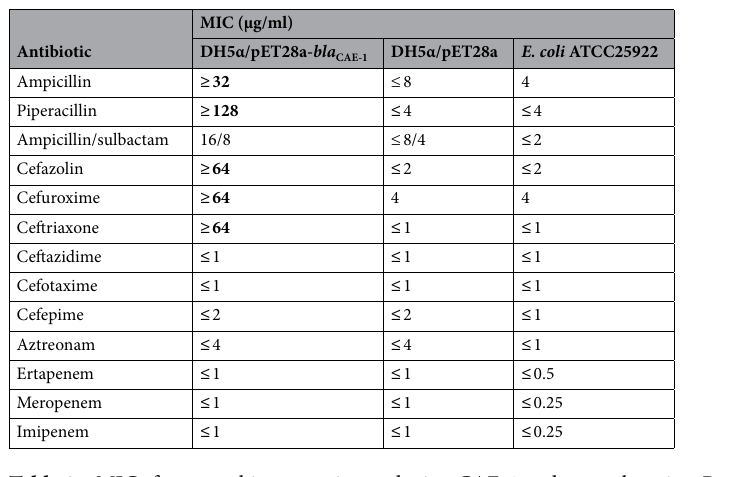
Table 2. MICs for recombinant strain producing CAE-1 and control strains. Resistant MIC ′ s are highlighted in bold.